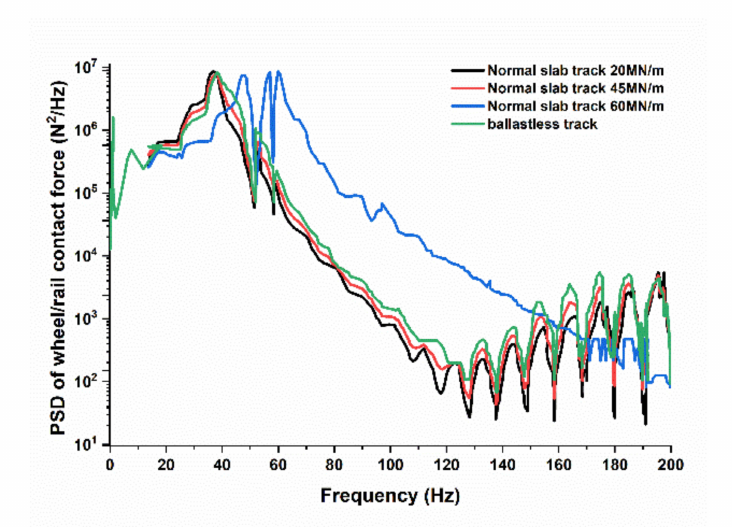
Figure 12. Power spectral density (PSD) of the wheel–rail contact force for a normal slab—i.e., 20, 40 and 60 MN/n—and ballastless